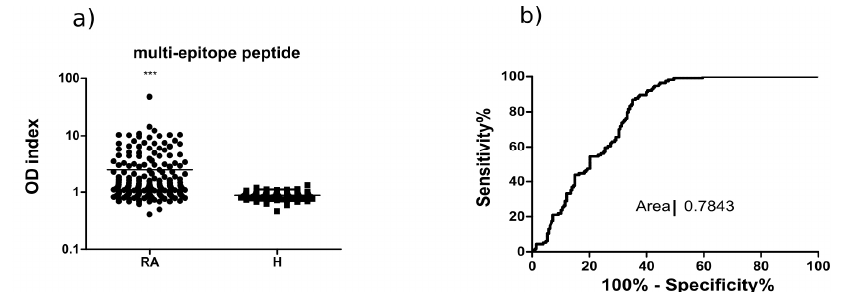
Figure 3. The Cit-multi-epitope peptide identifies RA sera with the highest specificity and 66% sensitivity: ( a ), ELISA, OD indexes (OD with Cit-peptide/OD with Arg-peptid) of RA ( n = 210) and healthy ( n = 90) samples, *** p ≤ 0.001; and ( b ) ROC curve of ELISA. Area under the curve (AUC): 0.7843.